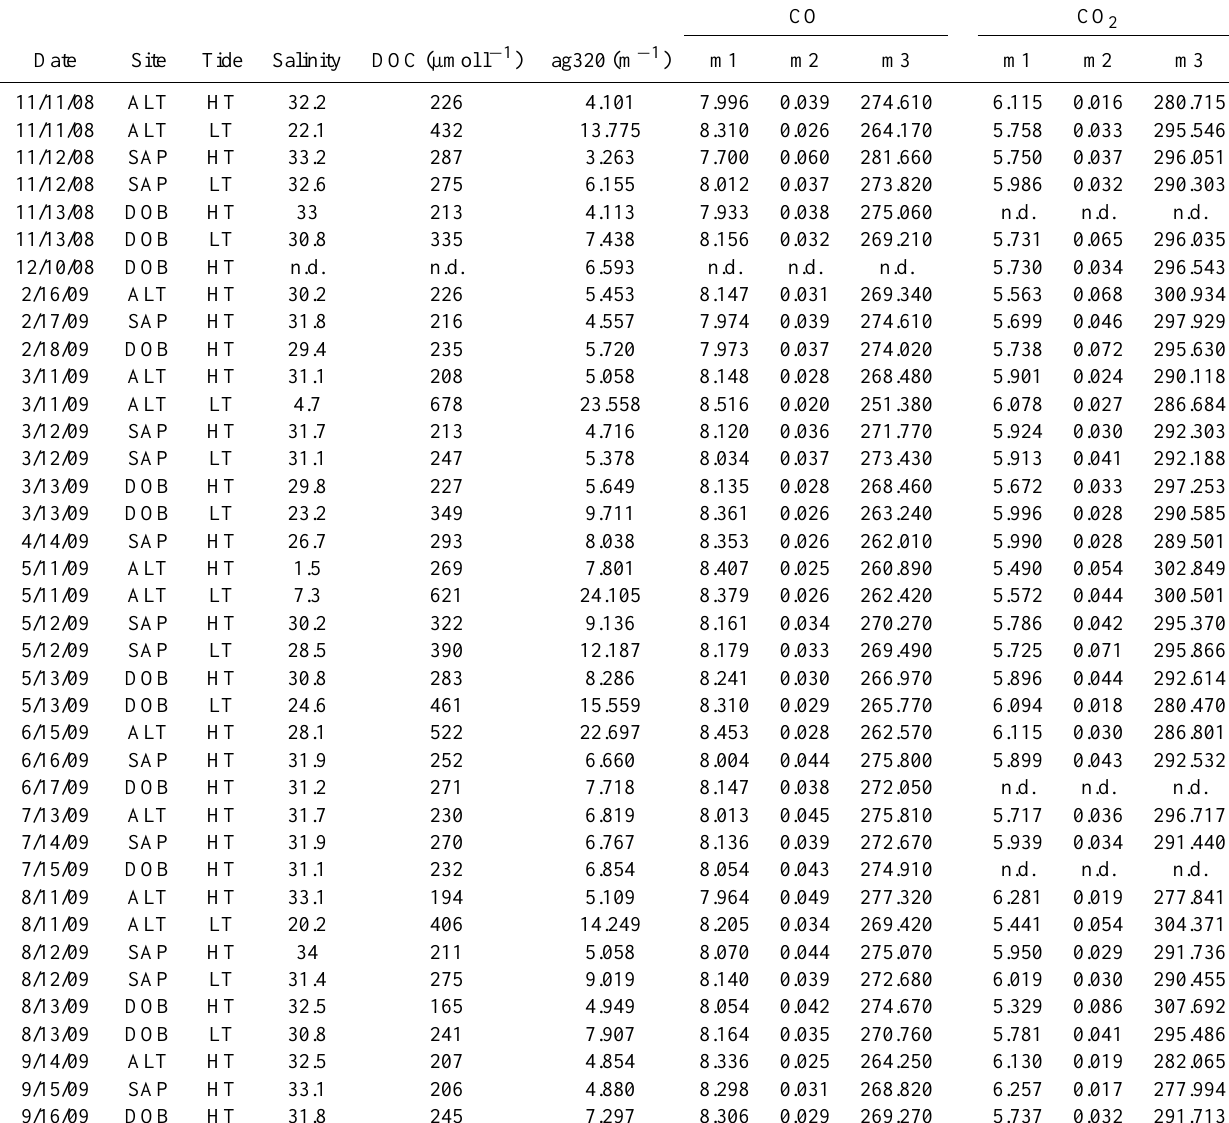
Table 1. Sample characteristics and AQY fitting parameters for all samples.